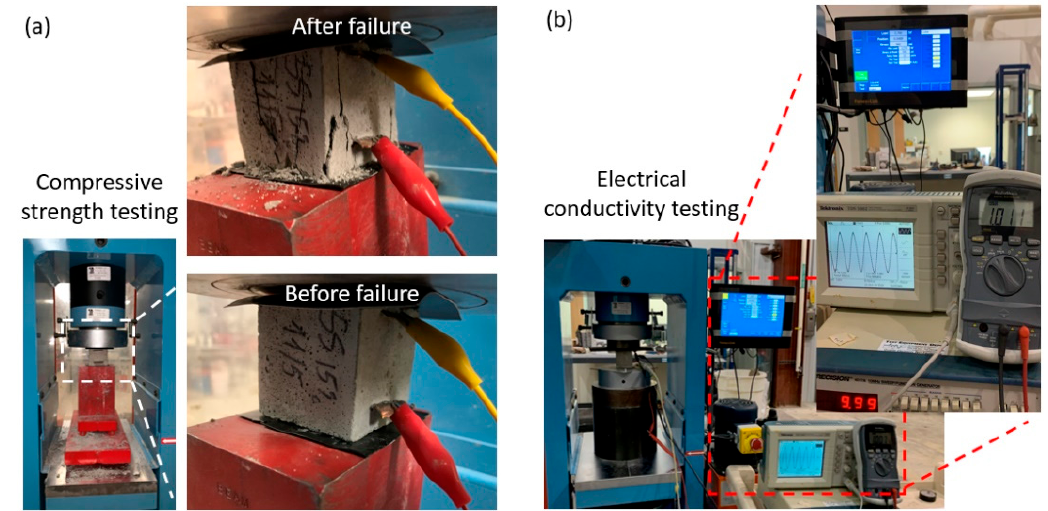
Figure 5. ( a ) Compressive strength test and ( b ) measuring electrical resistivity test.